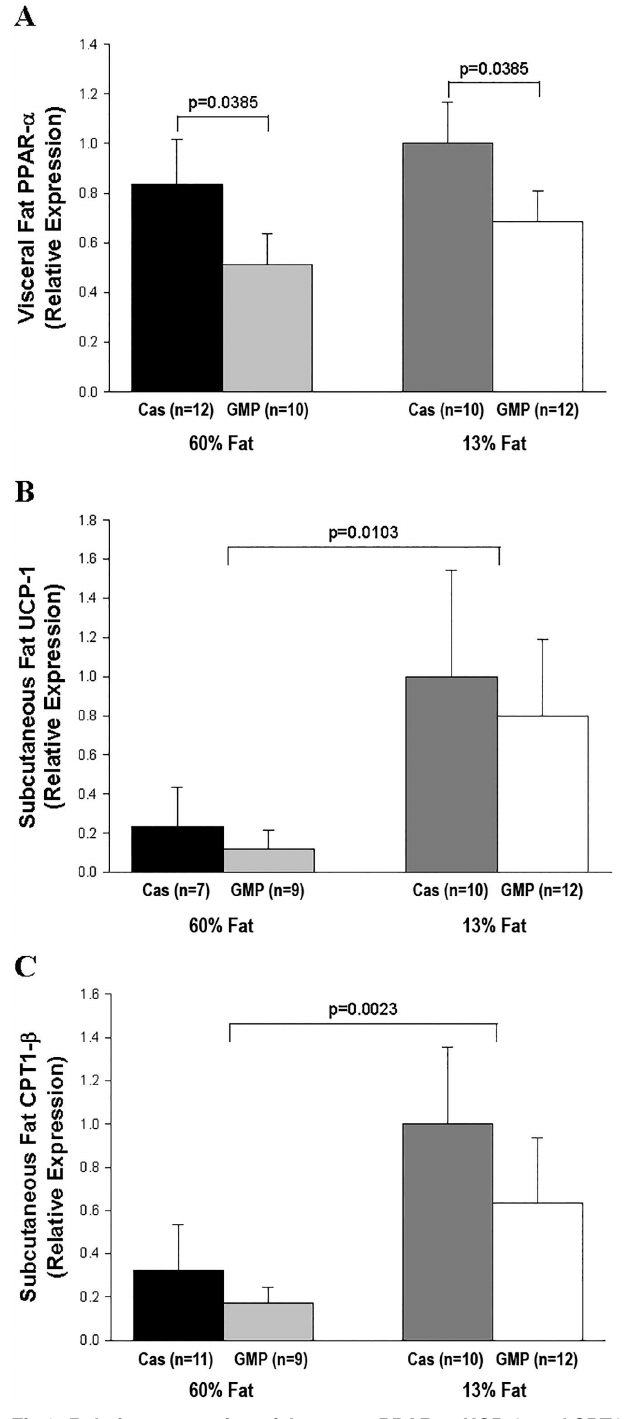
Fig 8. Relative expression of the genes PPAR- α , UCP-1, and CPT1- β . Relativeexpressionof the genes PPAR- α (A) in visceral fat tissue and UCP-1 (B) and CPT1- β (C) in subcutaneous fat tissue by quantitative real-time PCR. The expressionlevels have been normalizedwith the average expression of the control gene cyclophilin. There was a significant protein effect in relative expression of PPAR- α where mice fed the GMP diets have reduced relative expression compared to mice fed the casein diets. There was a significant fat effect in relative expression of UCP-1 and CPT1- β where mice fed the high-fat diets have reduced relative expression compared to mice fed the control